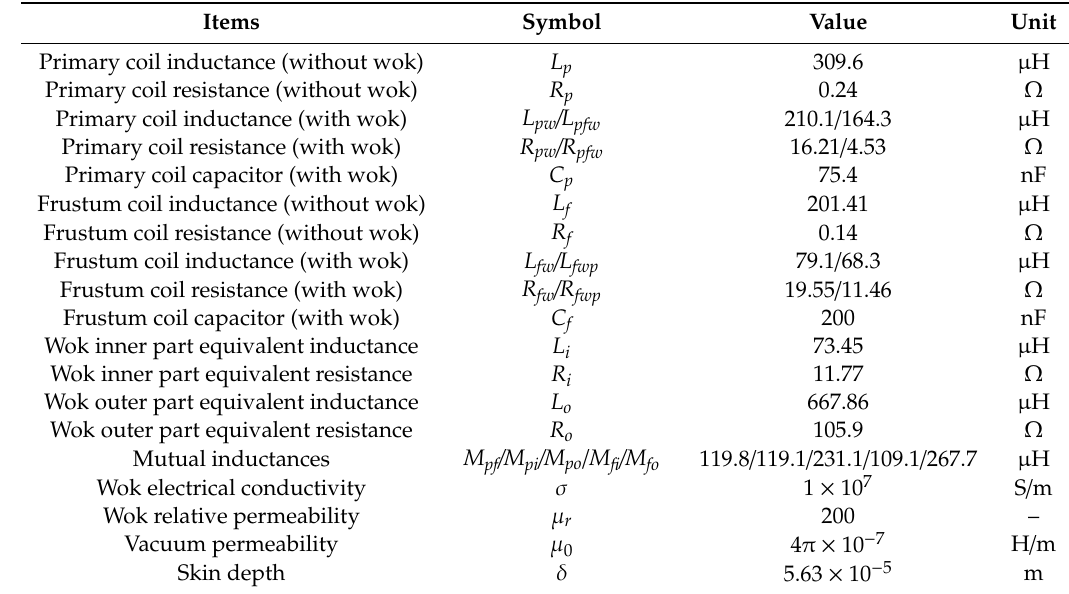
Table 1. Key parameters of the coils and the